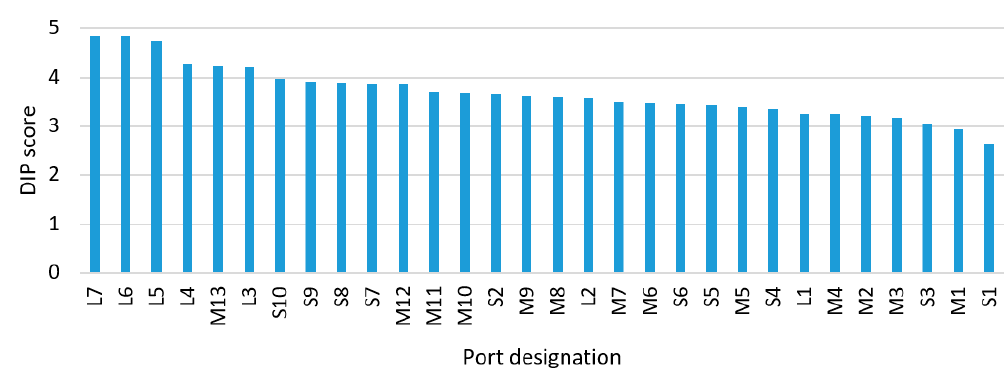
Figure 8. Ranking of analysed ports’ DIP score.